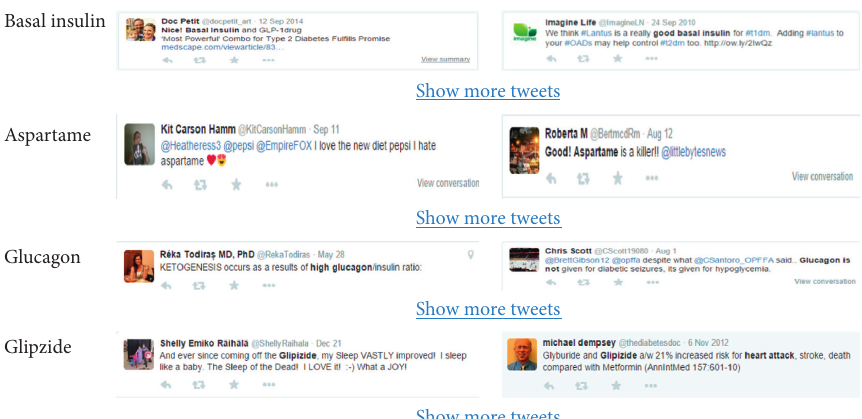
Figure 5: Data recommendation to diabetic persons.